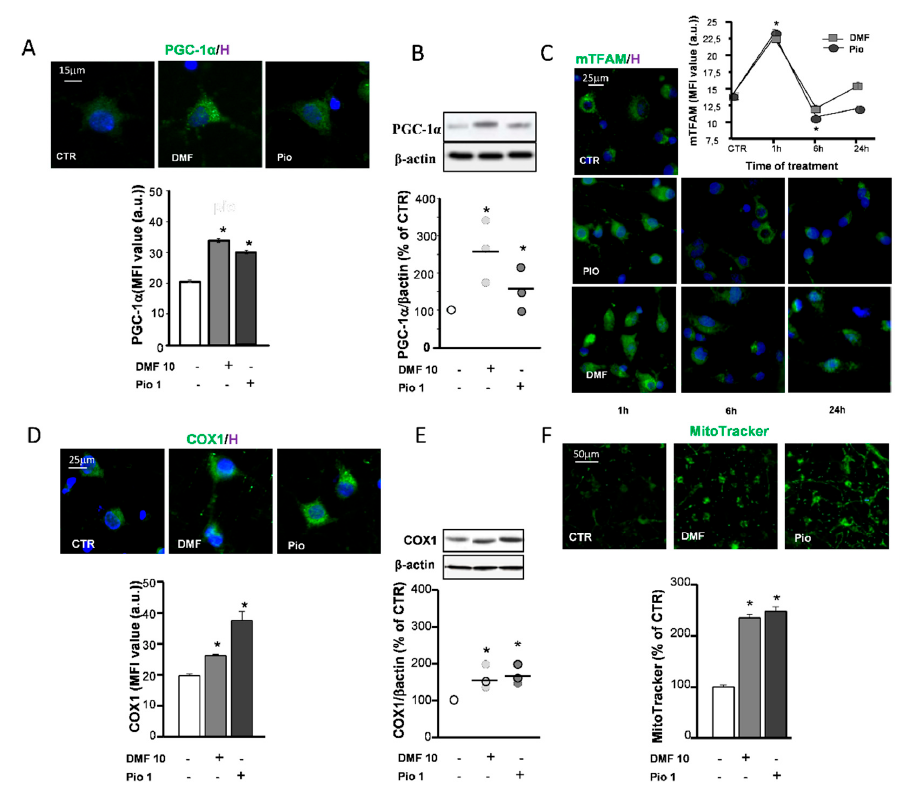
Figure 3. DMF and pio induce mitochondrial biogenesis. OP cultures treated for 24 h with 10-µM DMF or 1-µM pio were processed for IF experiments with PPAR- γ coactivator-1 α (PGC-1 α ) ( A ). The micrographs show PGC-1 α (green) and Hoechst 33258 nuclear fluorochrome (blue, H). The bar graph shows MFI analysis (MFI ± SEM from n = 250–300; * p < 0.05 vs. CTR). WB analysis of PGC-1 α expression is shown ( B ). Representative bands of β -actin and PGC-1 α are shown above; densitometric analysis is shown as mean and individual data points in the graph below ( n = 3; * p < 0.05 vs. CTR). OP cultures treated for different time points (1, 6, and 24 h) with 10-µM DMF or 1-µM pio were immunostained for transcription factor A (TFAM) ( C ). The micrographs show TFAM (green) and Hoechst 33258 (blue, H). The graph shows the MFI analysis ( n = 250–300 cells; * p < 0.005 vs. CTR). OP cultures treated with 10-µM DMF or 1-µM pio were processed for IF experiments with complex IV core protein (COX-1) ( D ). The micrographs show COX-1 (green) and Hoechst 33258 (blue, H ). The bar graph shows the MFI analysis ( n = 250–300 cells; * p <0.05 vs. CTR). WB analysis of COX-1 expression is shown ( E ). Representative bands of β -actin and PGC-1 α are shown above; densitometric analysis is shown as mean and individual data points in the graph below ( n = 3; * p < 0.05 vs. CTR). OP cultures were treated with 10-µM DMF or 1-µM pio and then loaded with the mitochondrial probe MitoTracker Green ( F ). MitoTracker fluorescence intensities were measured from single cells, and mean ± SEM are shown in the bar graph. CTR is taken as 100% ( n = 308–460 cells; * p < 0.05 vs. CTR).